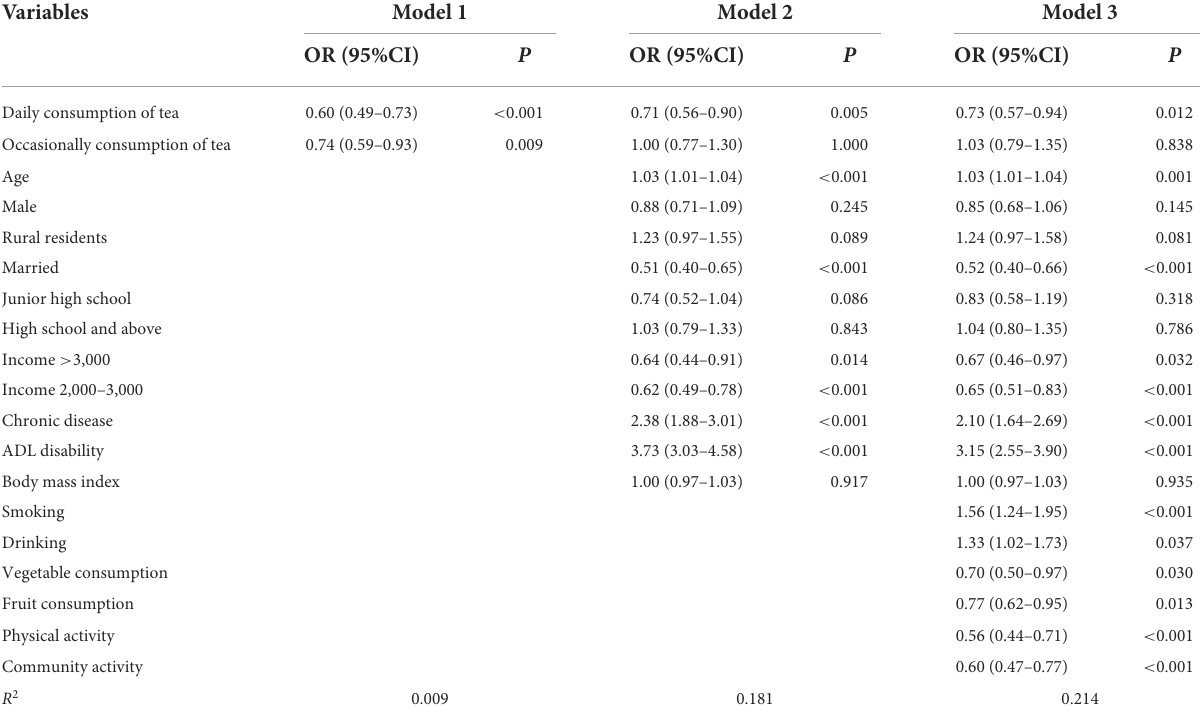
TABLE 2 Associations between tea consumption and frailty among whole